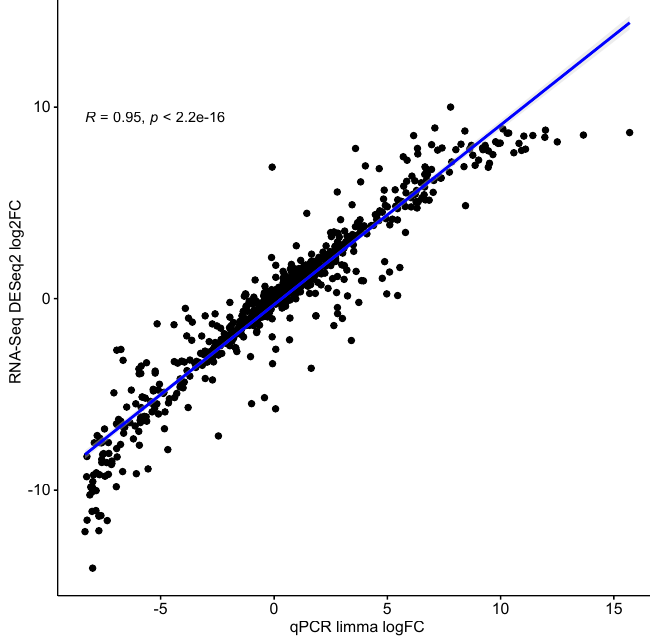
Figure A4. Logarithmized fold change correlation between limma results of qRT-PCR and pipeline results ( DESeq2 ) of RNA-Seq data filtered by adjusted p -value ≤ 0.001 of limma results. The correlation was calculated by the Pearson